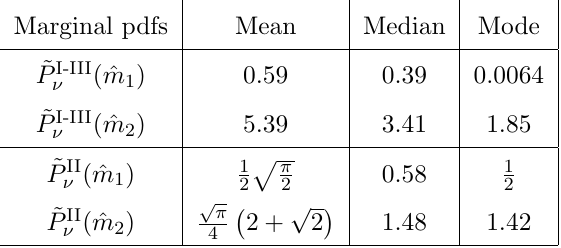
Table 1 . Location parameters for the marginal singular value pdfs of (cid:12)gure